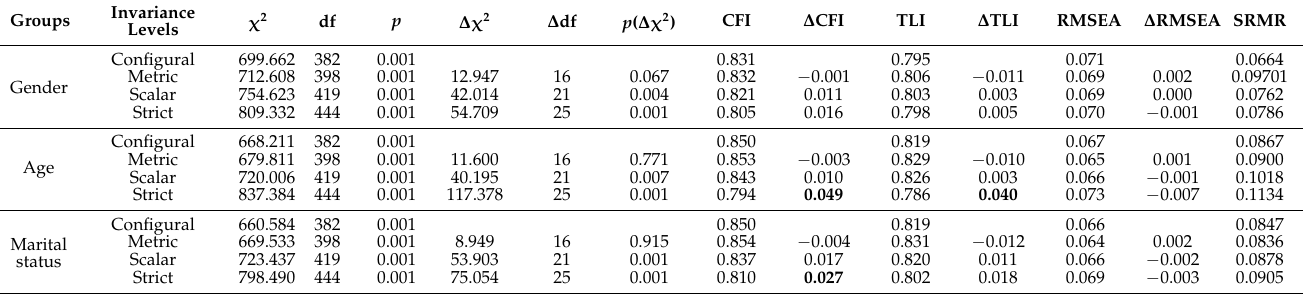
Table 4. Invariance of the six-factor structure (Model 7) of the Arabic version of the Impact of Event Scale-Revised (IES-R) across groups of gender, age, and marital status among psychiatric patients.